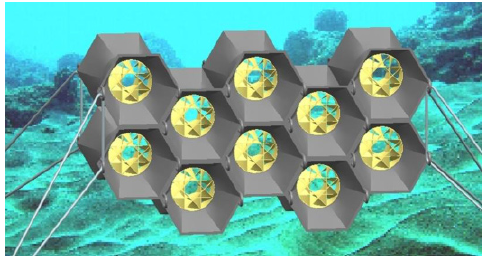
Figure 7. Concept of the FTE Tidal system-SEACATS.